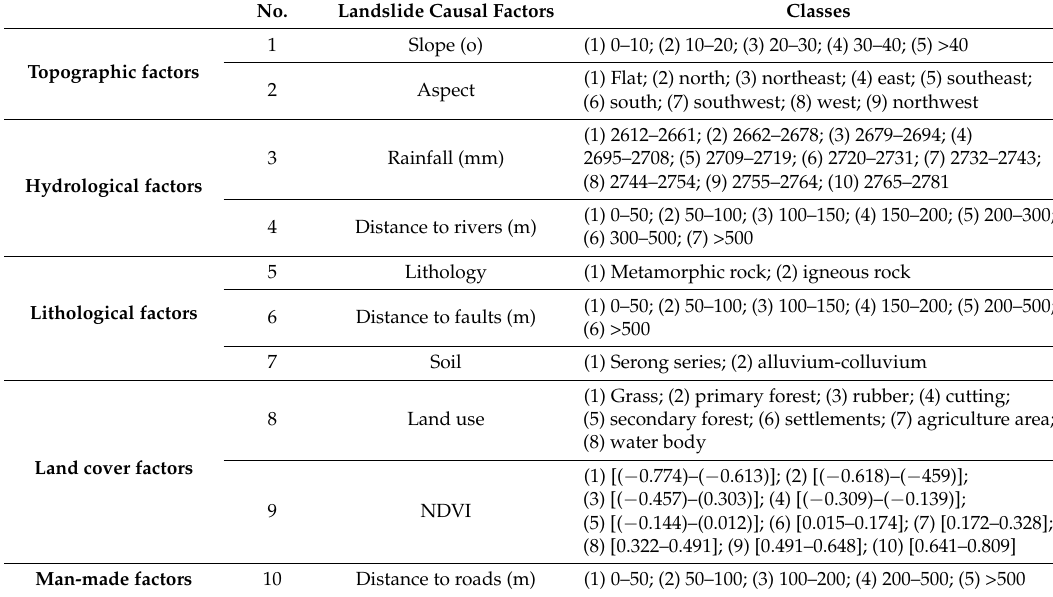
Table 3. Landside influencing factors and their